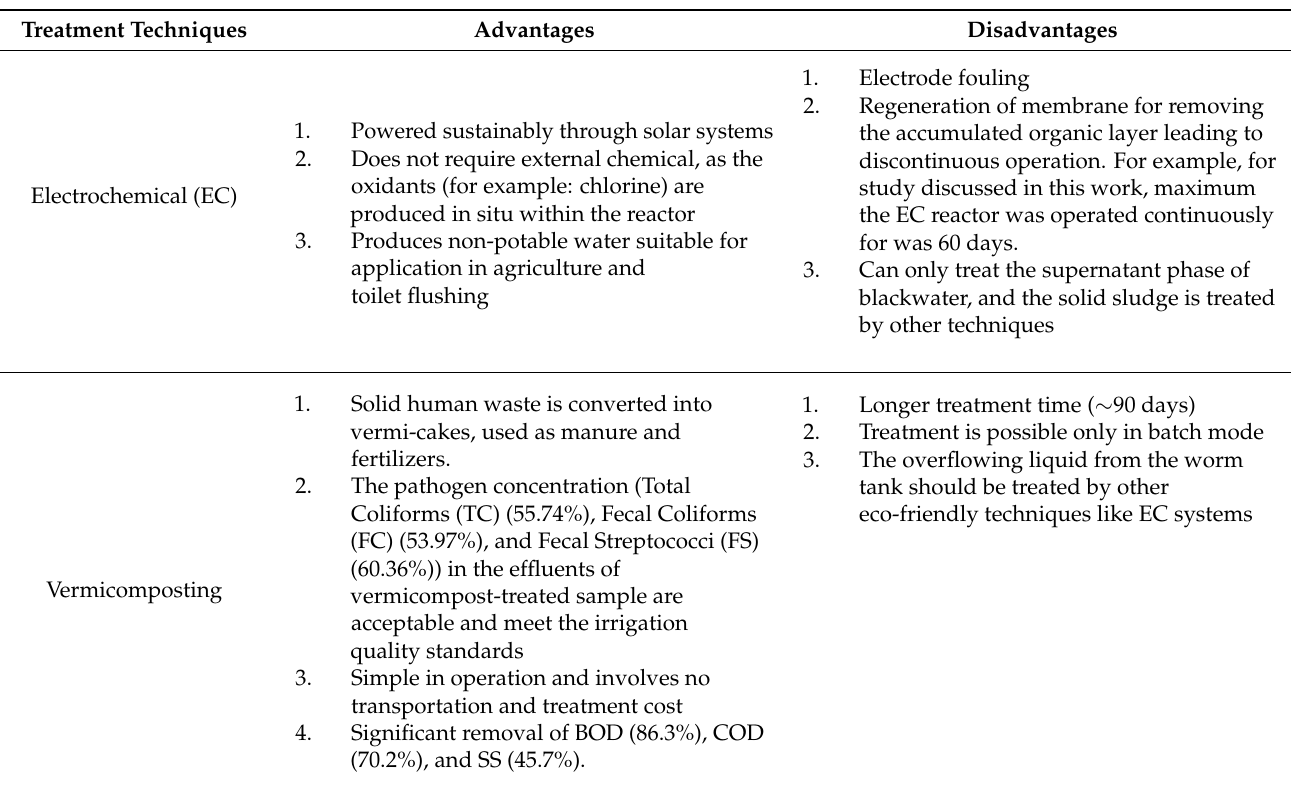
Table 3. Comparison of diverse novel techniques for the treatment of BW and their corresponding advantages and